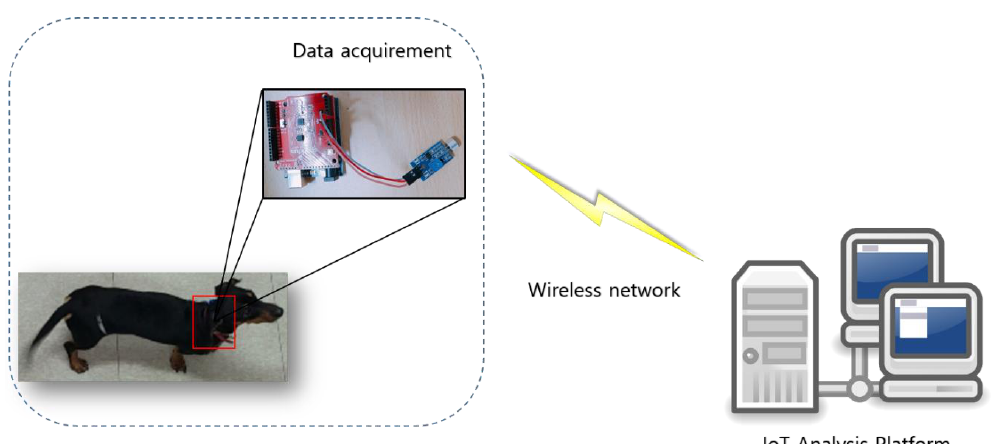
Figure 2. Intensity data acquisition using noise sensor. The noise sensors are used to collect intensity data and the collected intensity data is transmitted over the wireless network to the IoT analysis platform to process the data.